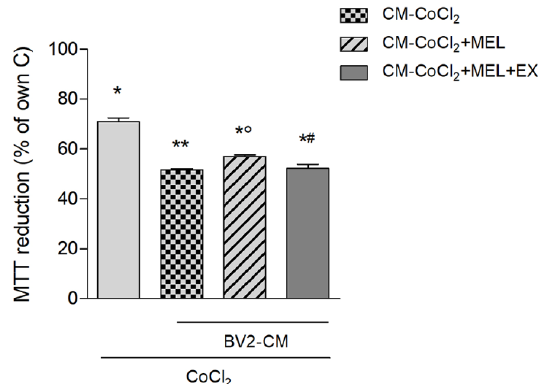
Figure 6. Melatonin attenuates NF-kBp65 upregulation by CoCl 2 in microglia. Western blot analysis ( a ) of NF-kBp65 levels in BV2 cells exposed to CoCl 2 (250 μ M for 8 h) alone, or in combination with either melatonin (1 μ M) or melatonin + EX527 (5 μ M). In ( b ), immunostaining of NF-kBp65 (green) and nuclear counterstaining with DAPI (blue) following exposure to CoCl 2 alone (250 μ M for 8 h), or in the presence of melatonin (1 μ M) + EX527 (5 μ M). Bars are mean ± SEM of three independent experiments. * p < 0.05 vs. control (C), ° p < 0.05 vs. CoCl 2 and # p < 0.05 vs. CoCl 2 + MEL by one-way ANOVA followed by Newman–Keuls test for statistical significance. Representative images are shown. Scale bar = 20 µ m.